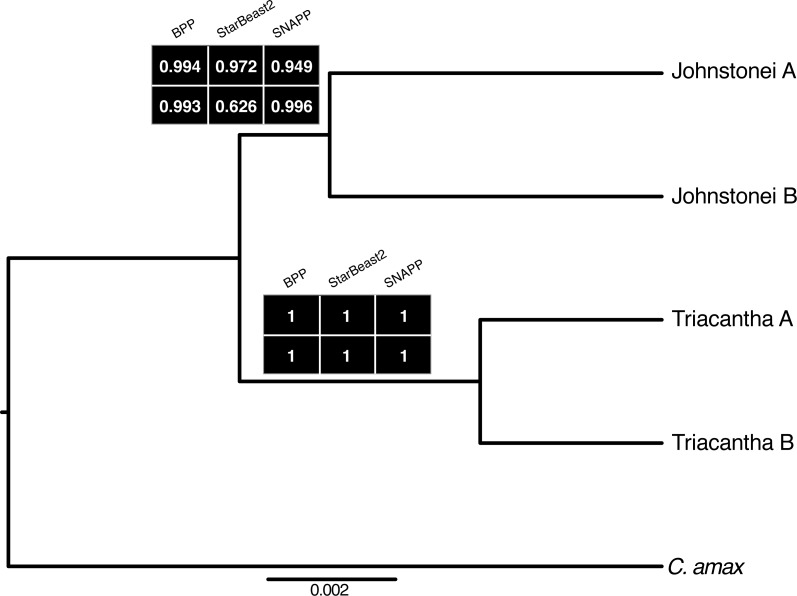
Species tree with topology from BFD StarBeast2 gene set1 presenting node posterior probabilities for the two sets of data used for all three MSC methods.